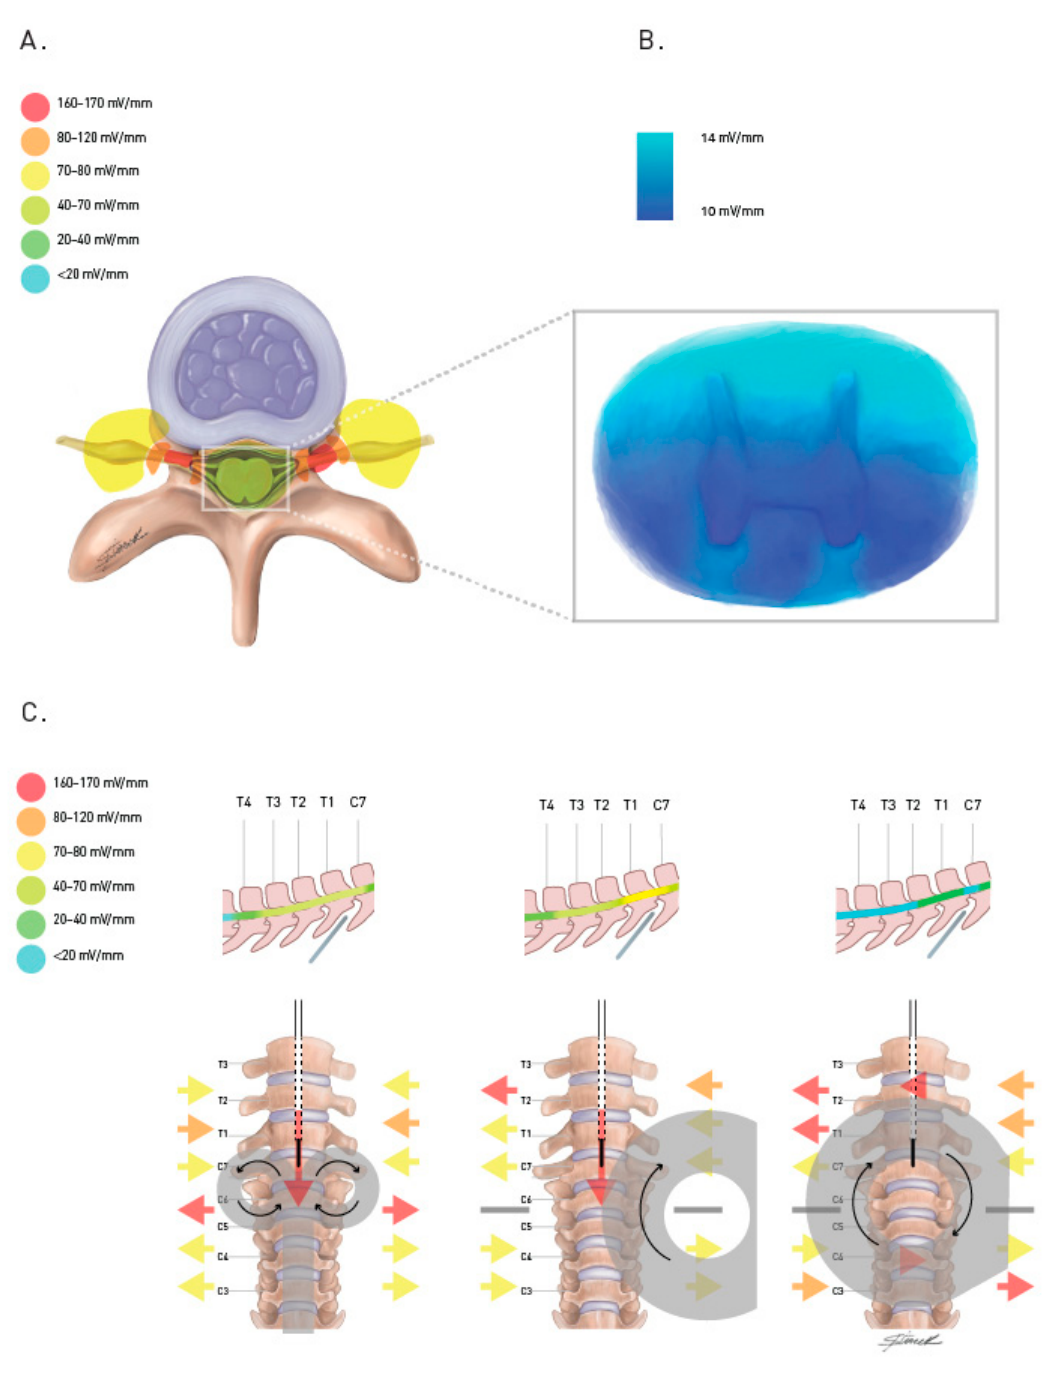
Figure 2. Transspinal magnetic stimulation induced electric fields, as suggested by the exploratory literature and computational models. ( A ). Generated current is concentrated on neuroforamina with estimated three to ten-fold greater intensity than at the spinal cord. ( B ). Current distribution in the spinal cord favors the posterior column, sparing the anterior horn and antero-lateral columns. ( C ). Generated current orientation on neuroforamina and spinal canal depends on coil type and positioning. Intraspinal transversal currents are substantially weaker than longitudinal currents when generated with similar coils. Root stimulation is optimal, leading to lower resting motor threshold and higher peak amplitudes when induced current is better aligned with the neuroforamina (orange and red arrows), preferably in an outwards direction (red arrow). mV/mm: millivolts per millimeter.